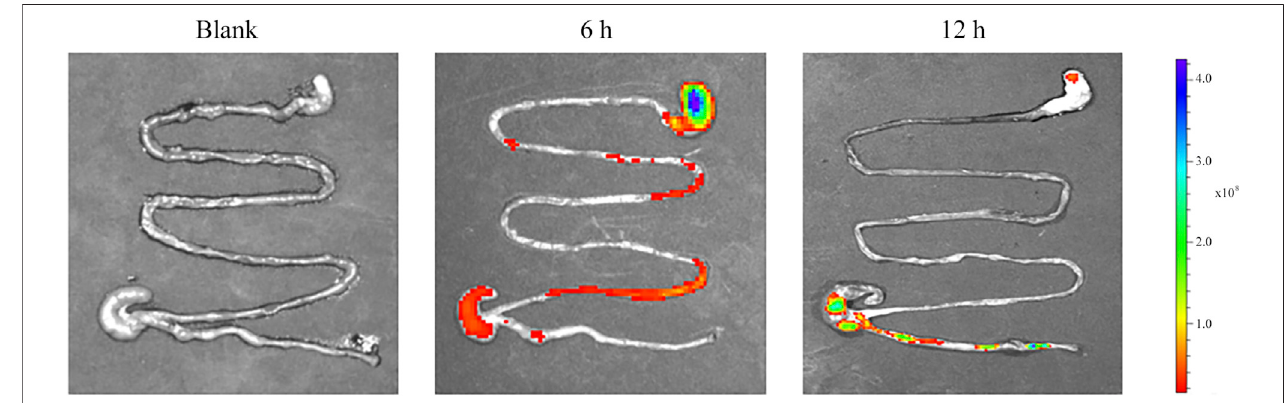
FIGURE 8 | Representative ex vivo images of the GIT after oral administration of blank and RBITC-loaded hydrogel, showing colon-targeted drug delivery and accumulation potential.